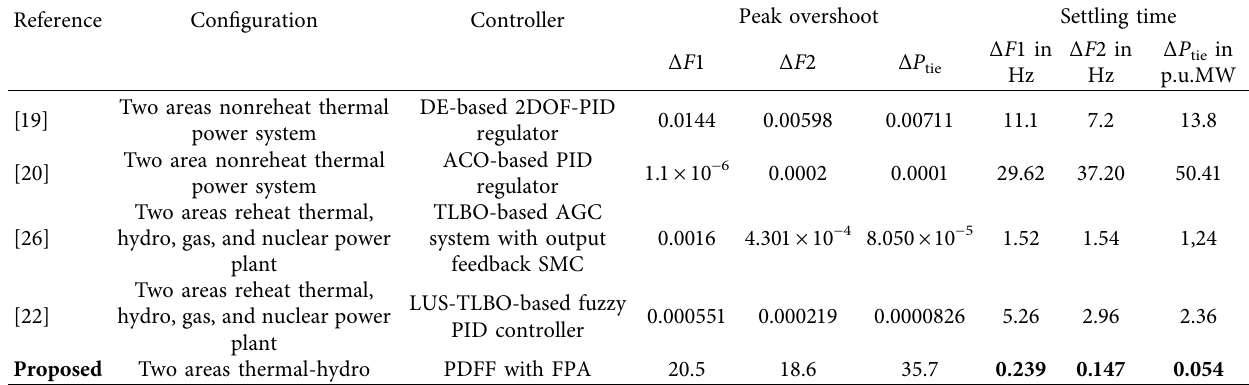
Table 5: Comparative analysis with the existing